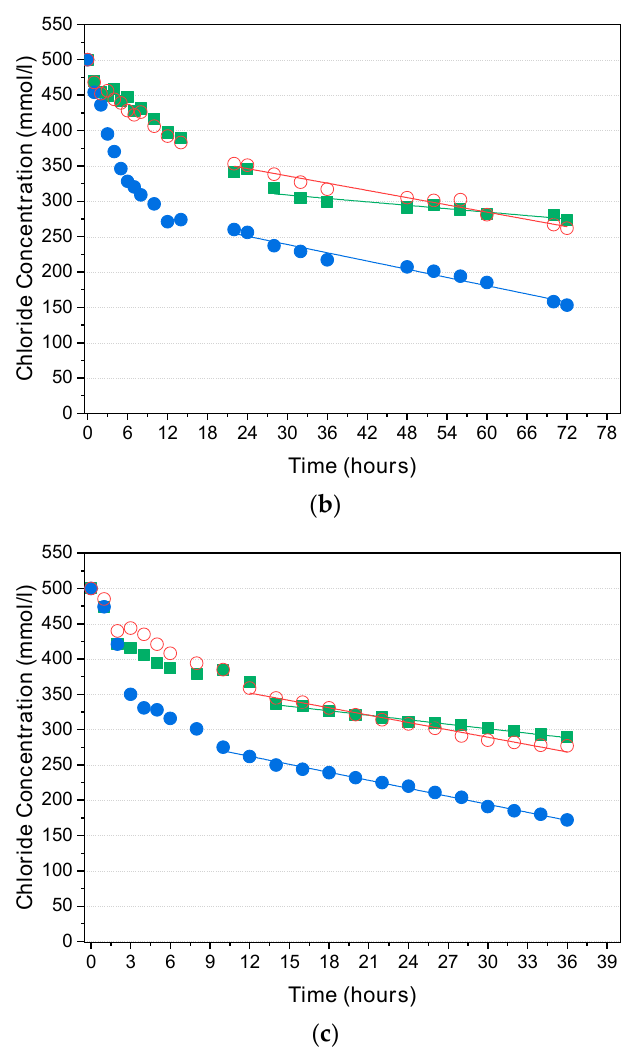
Figure 4. Chloride concentration drops in the upstream cell: ( a ) 12 V; ( b ) 24 V; ( c ) 36 V.